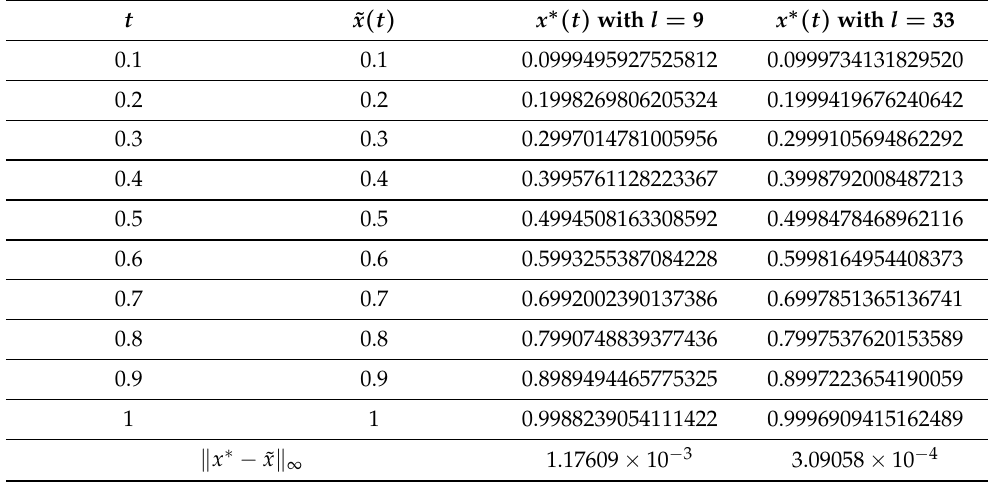
Table 4. Numerical results for (18) with initial x 0 ( t ) = sin ( t ) .